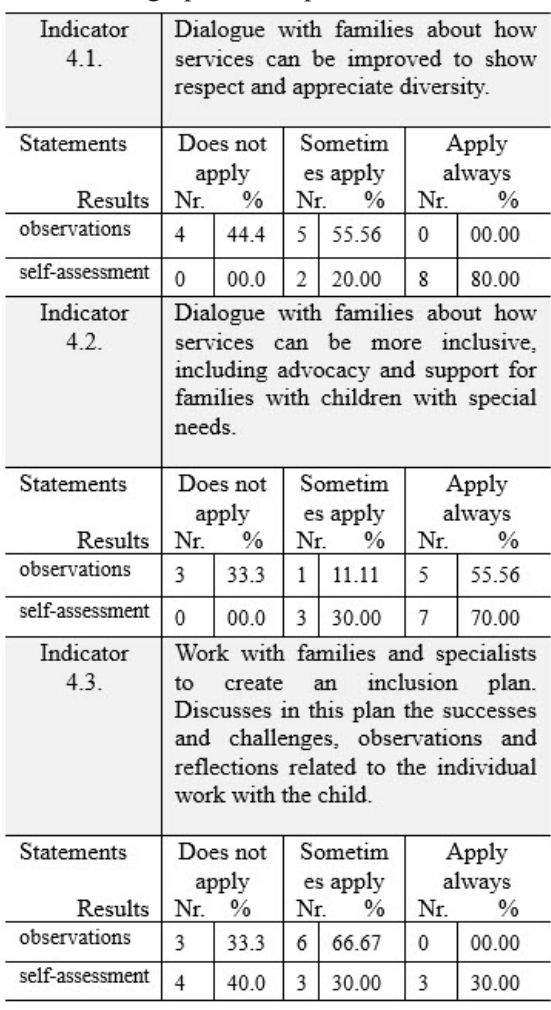
Table 13. Principle 4: Inclusion is pro - moted through partnerships with